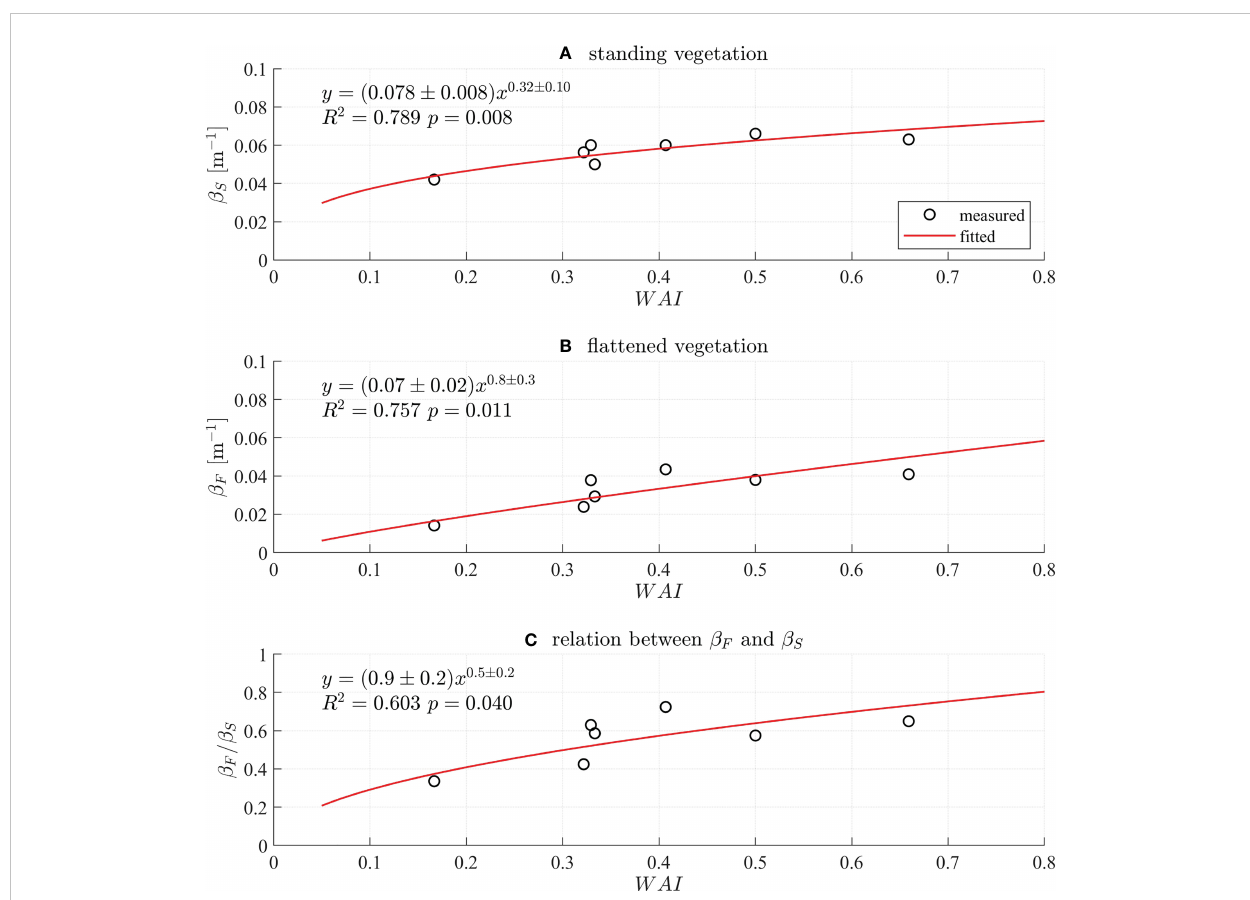
FIGURE 4 Empirical formulas for the wave damping coef fi cient of (A) standing vegetation ( b S , m – 1 ) and (B) fl attened vegetation ( b F , m – 1 ) with respect to WAI de fi ned in (3). (C) Relation between b F and b S as a function of WAI